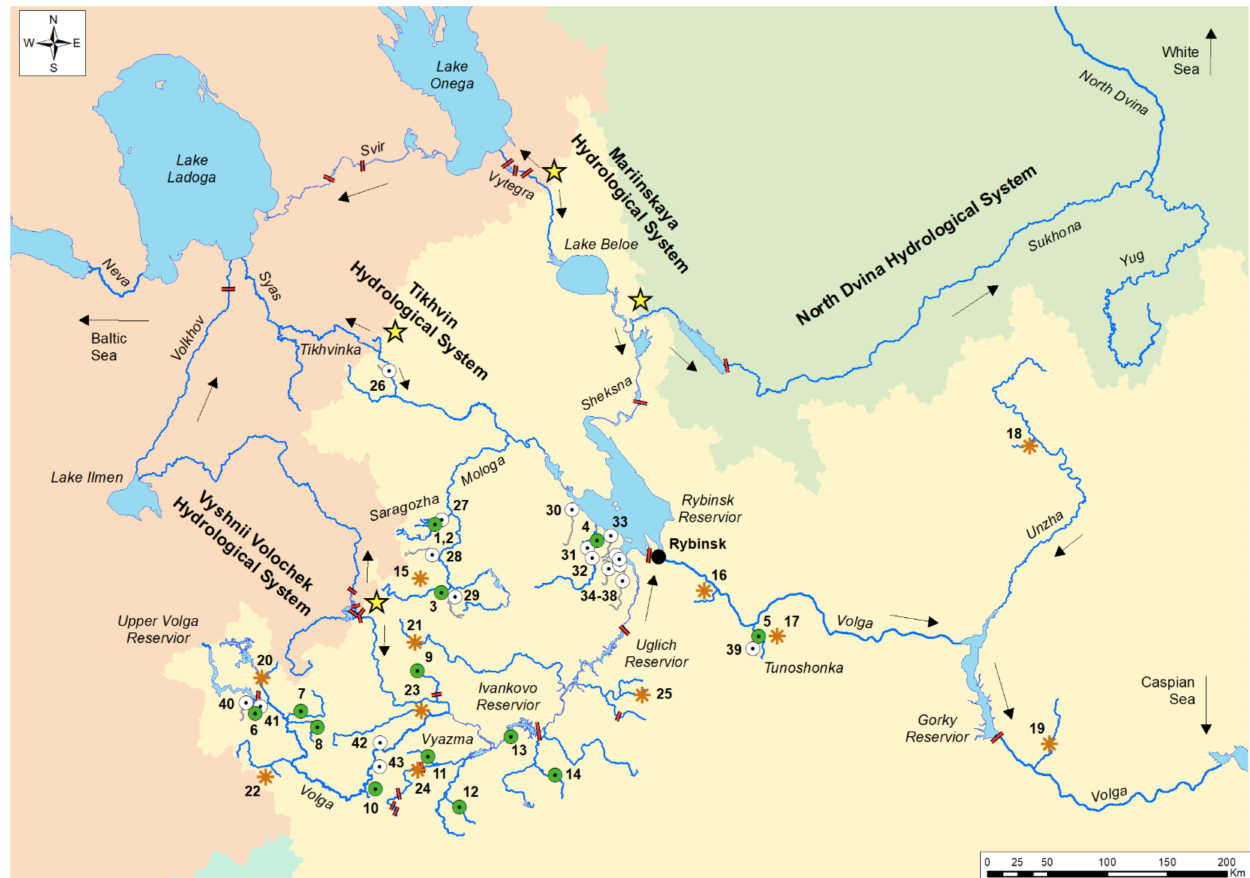
Figure 2. Generalized map of the study area and survey sites. Own sampling and observation sites ( ): Vysochinsky Stream and its unnamed tributary (1); Saragozha River (2), Volchina River (3), Kamenka River (4), Tunoshonka River (5), Malaya Dubenka River (6), Bolshaya Kosha River (7), Malaya Kosha River (8), Shutinka Stream (9), Kava River (10), Vyazma River (11), Bolshaya Sestra River (12), Volga River (13), and Yakhroma River (14). Distribution of the Europea river lamprey in the Upper Volga basin according to the literature ( ): Serednitsa River [26] (15), Pechegda River (16),